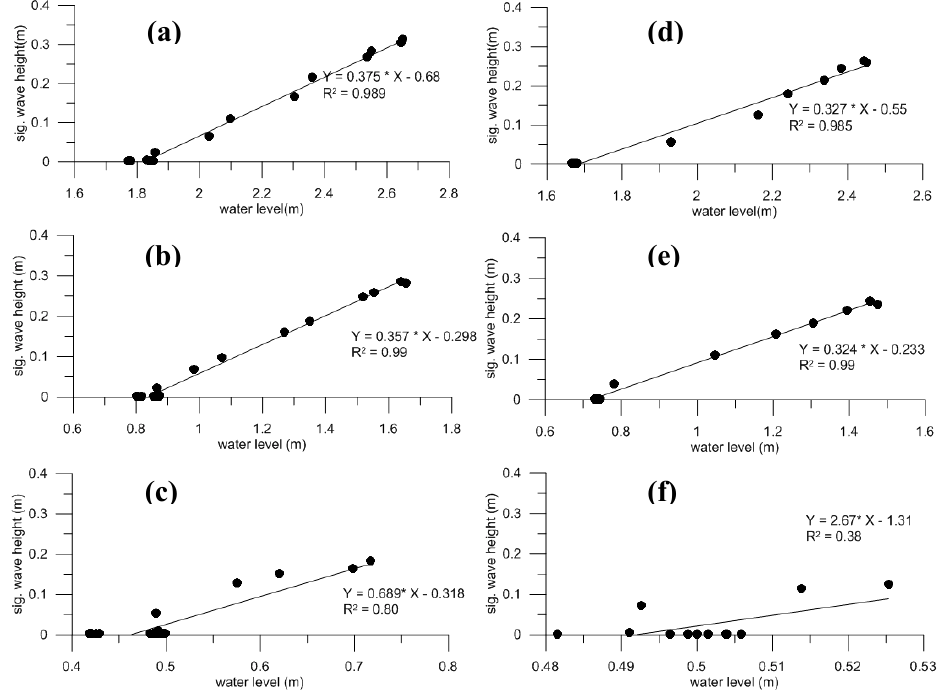
Figure 6. Relationship between water level and significant wave height in the study region on 5 August 2015 (left) and 6 August 2015 (right) at the locations P1 ( a,d ), P2 ( b,e ), and P3 ( c,f ).